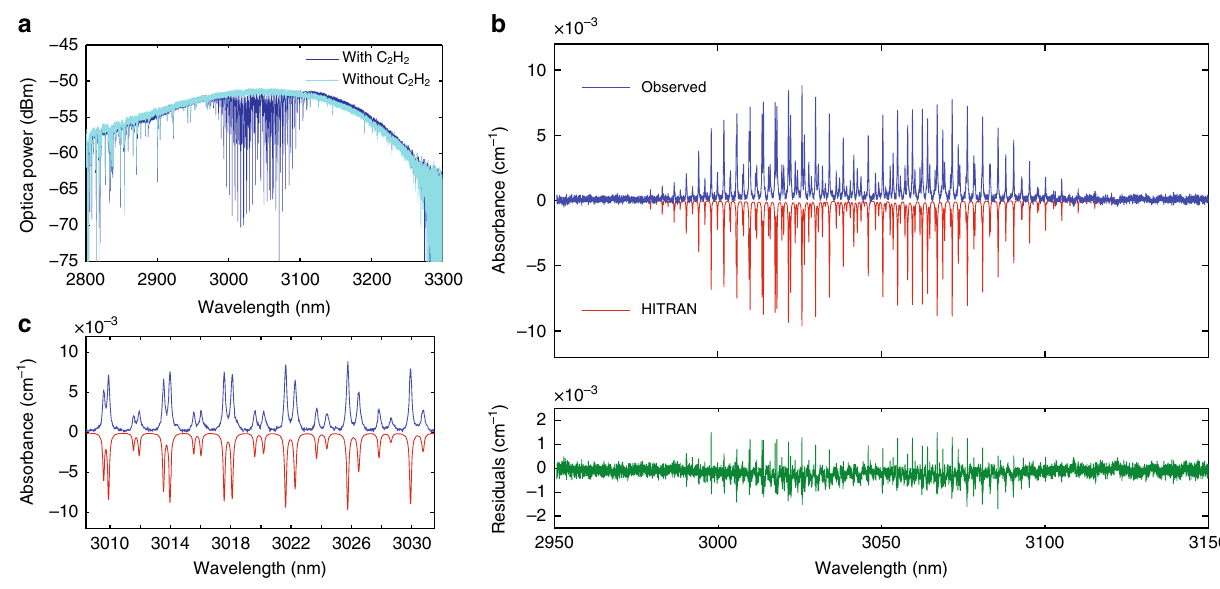
Fig. 5 Mid infrared gas spectroscopy. a Transmitted spectrum of the empty (light blue) or fi lled (dark blue) gas cell with C 2 H 2 in N 2 buffer gas at 1 atm total pressure. b Observed absorbance (dark blue) with the gas cell fi lled with C 2 H 2 in N 2 buffer gas by normalizing the sample spectrum to that of the pure N 2 reference gas in the cell, theoretical absorbance (HITRAN) (in red and inverted for clarity), and the residuals (green), differences between simulations and experimental data, of the multiple-line fi t. c Zoom on the observed and HITRAN